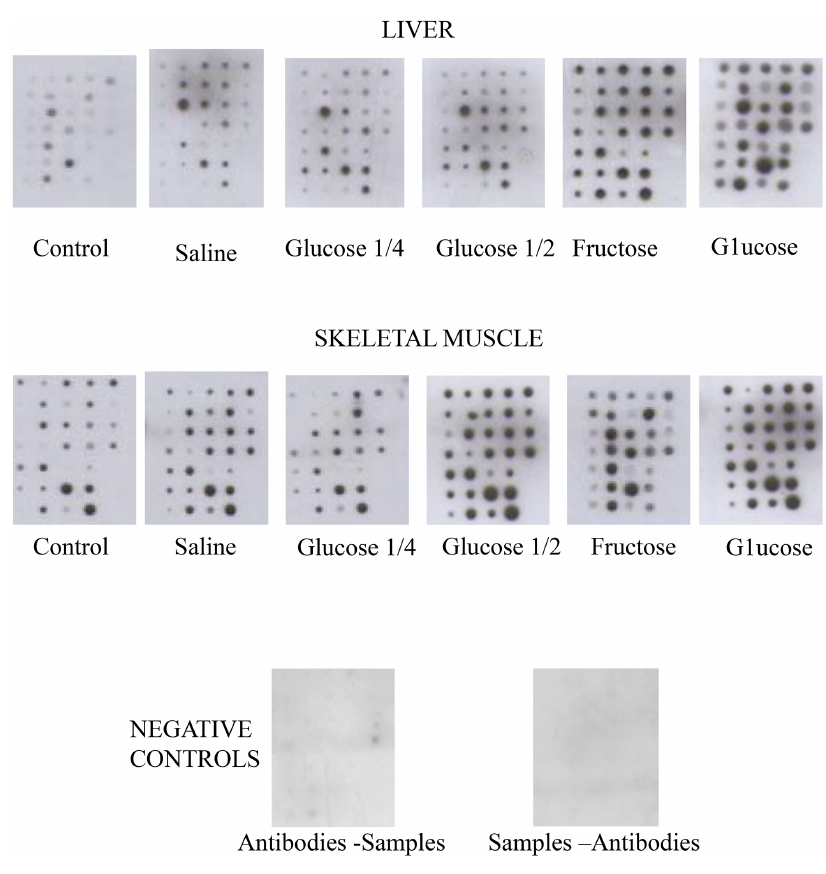
Figure 2. Mini-array analysis of the serine phosphorylation status of several proteins involved in overall cell function and the regulation of cell cycle in whole rat liver and skeletal muscle after oral loading of different amounts of glucose and fructose. The mini-array analysis and the distribution of the proteins are described in the Material and Methods section and Figure 1. Healthy adult rats were subjected to an oral glucose or fructose load, as described in the Material and Methods section. The serine-phosphorylation levels of each spot in the mini-arrays were then analyzed. Control: rats that were not subjected to an oral load. Saline: rats subjected to a mock oral load with xx mL of saline solution (0.9%; w/v, NaCl in fresh drinking water). Glucose 1/4: animals subjected to an oral load of 65 mg glucose/100 g body weight. Glucose 1/2: animals subjected to an oral load of 125 mg glucose/100 g body weight. Glucose: animals subjected to an oral load of 250 mg glucose/100 g body weight. Fructose: animals subjected to an oral load of 280 mg fructose/100 g body weight. C-: negative controls. Liver: whole liver extracts. Muscle: whole skeletal muscle extracts. The Figures shows a representative image for five separate experiments. Negative controls were designed as described in the Material and Methods